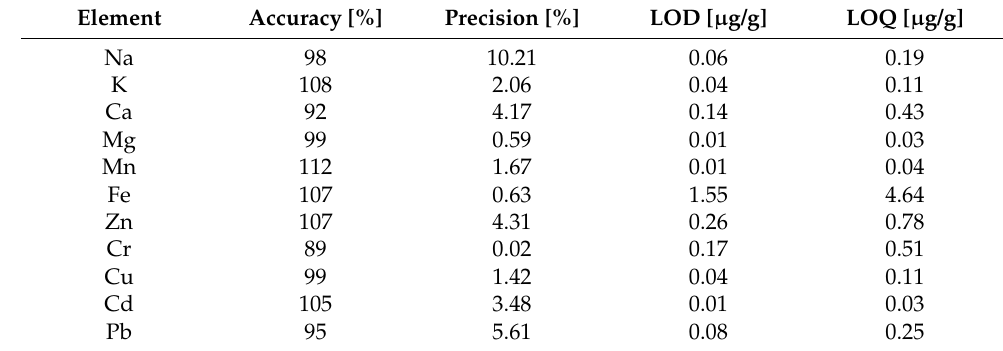
Table A2. Validation parameters for the FAAS